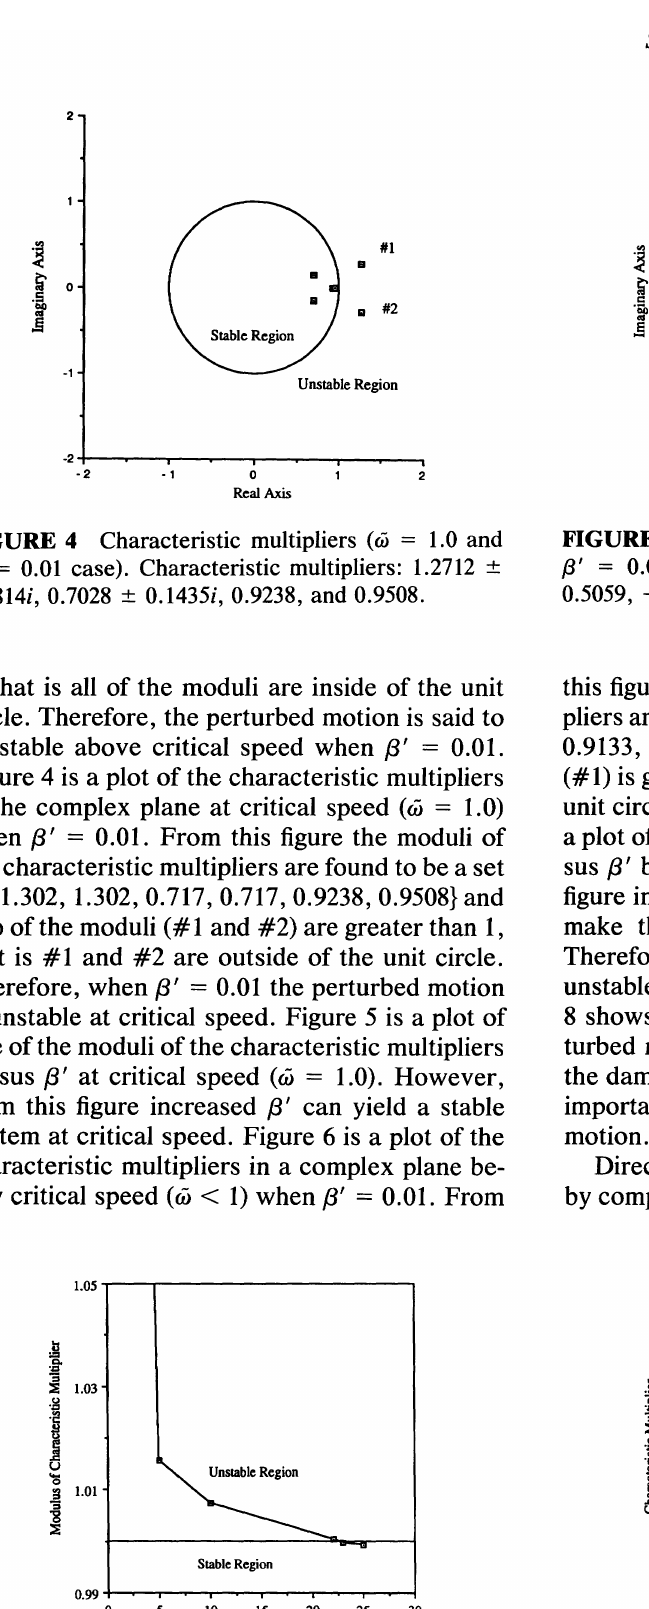
FIGURE 7 Modulus of characteristic multiplier ver sus {3' (eli = 0.9